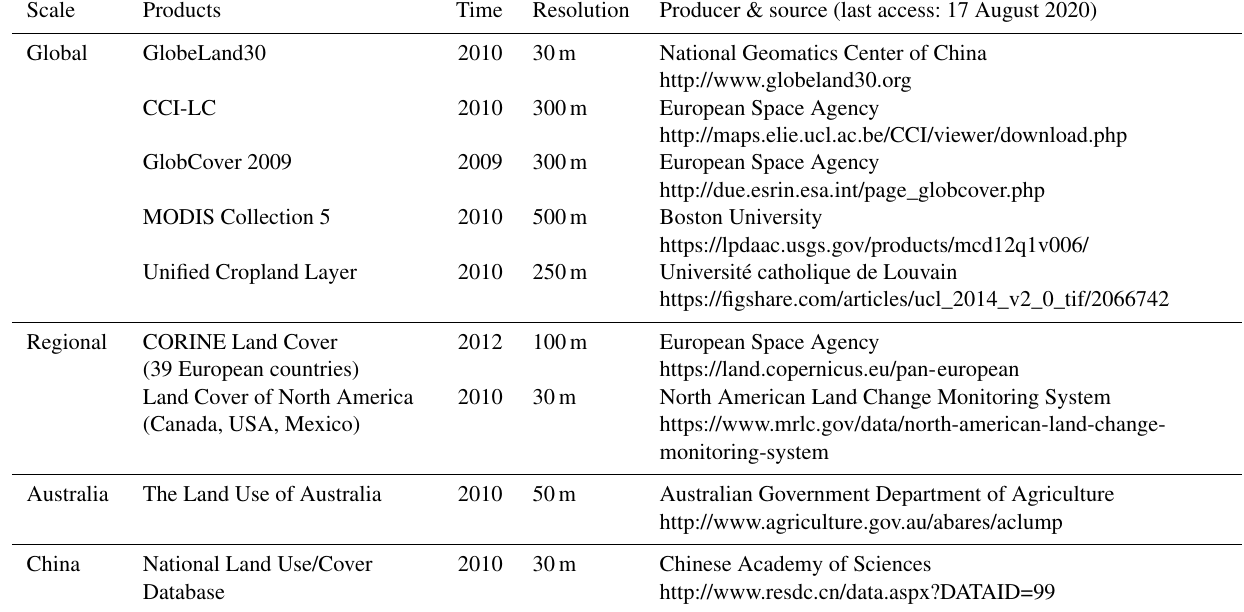
Table 1. Input satellite-based